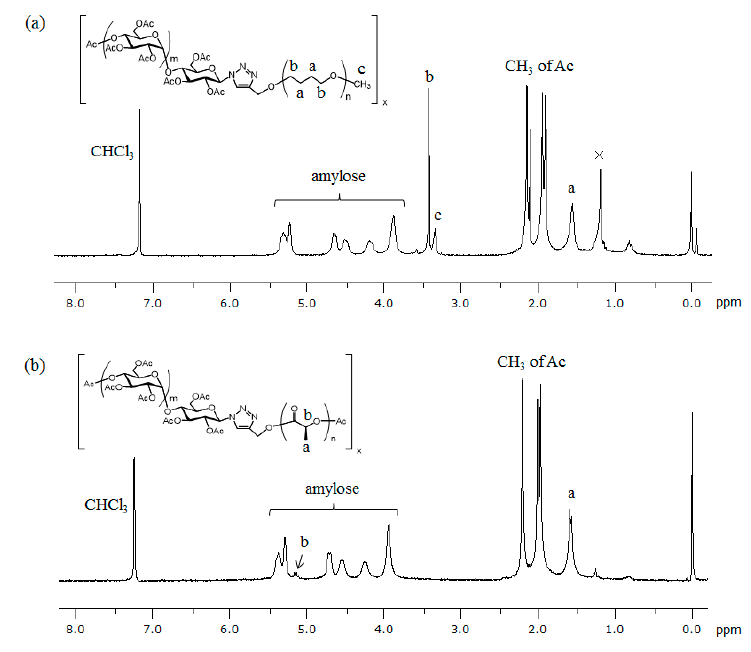
Figure 6. 1 H NMR spectra of: ( a ) ATA–PTHF and ( b ) ATA–PLLA supramolecular polymers (CDCl 3 ).